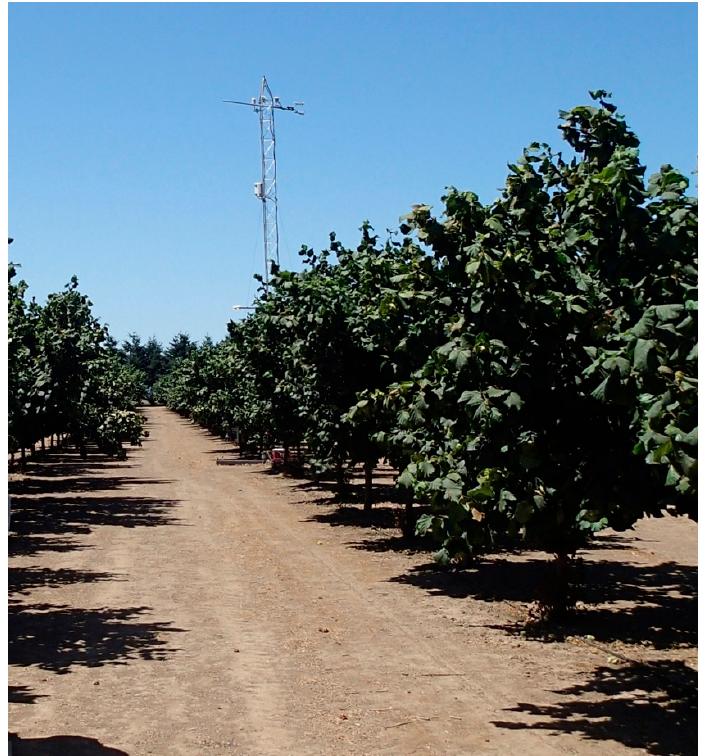
Figure 2. Photograph of experimental site 2 (Hazelnut orchard) showing the eddy-covariance system, net radiometer and other sensors on a 10-m tower in background.